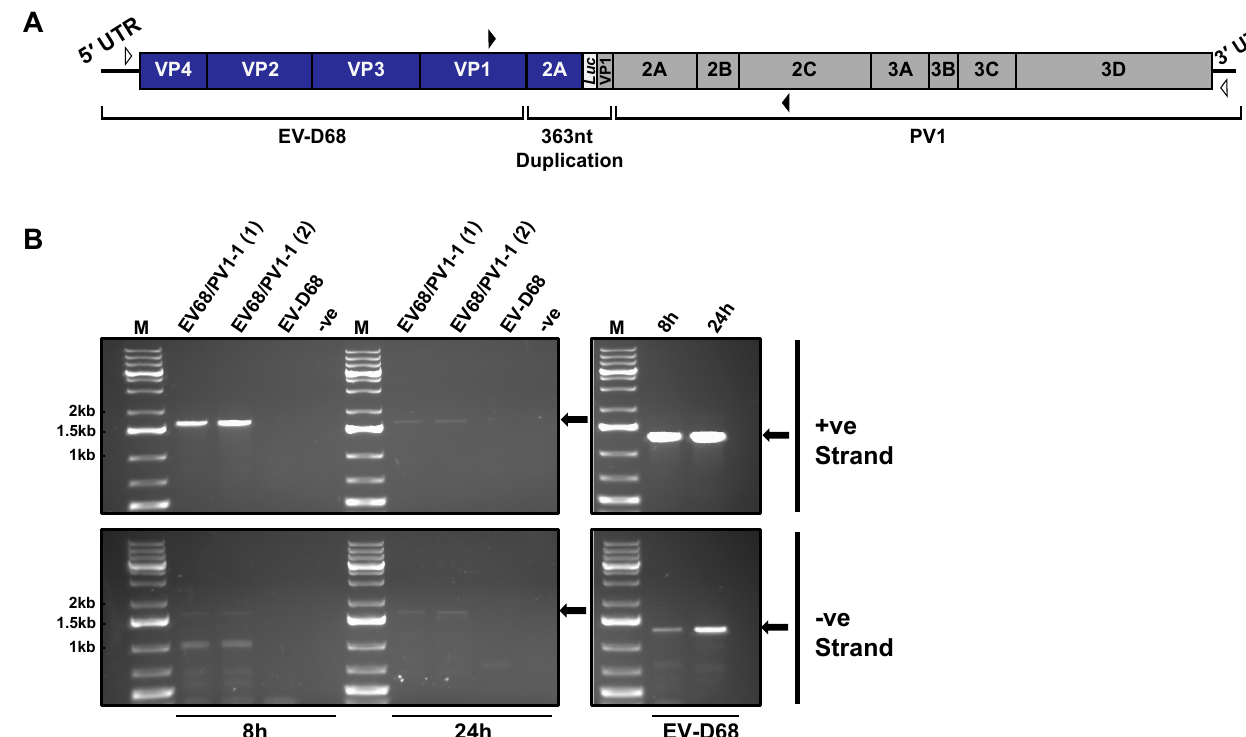
Figure 6. Replication of inter-species recombinant EV68/PV1-1: ( A ) schematic of inter-species recombinant genome EV68/PV1-1. Open arrowheads mark positions of primers for cDNA synthesis and closed arrowheads mark positions of primers for PCR; ( B ) PCR assay for negative- and positive-strand RNA. Left-hand panels denote amplification of recombination window with primers specific to the recombinant (EV68(F) and PV1(R)), and right-hand panels denote amplification of EV-D68 controls with EV-D68 specific primers (EV68(F) and EV68(R)). Amplification from positive-strand (upper panels) and negative-strand (lower panels) RNA is shown. Arrows indicate expected product sizes.